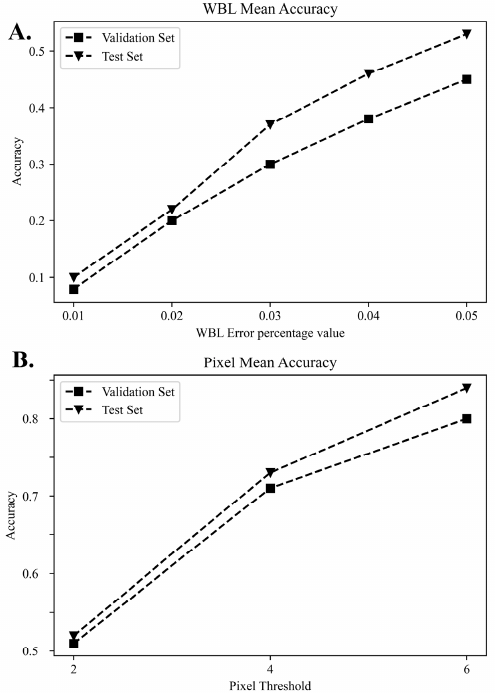
Figure 5. Graph of the WBL mean accuracy. ( A ) Accuracy graph of the WBL error percentage value, ( B ) accuracy graph of the pixel threshold. Validation set: the data sample used to provide an unbiased evaluation of a model fit on the training dataset while tuning the model hyperparameters. Test set: the sample of data used to provide an unbiased evaluation of a final model fit on the training dataset.